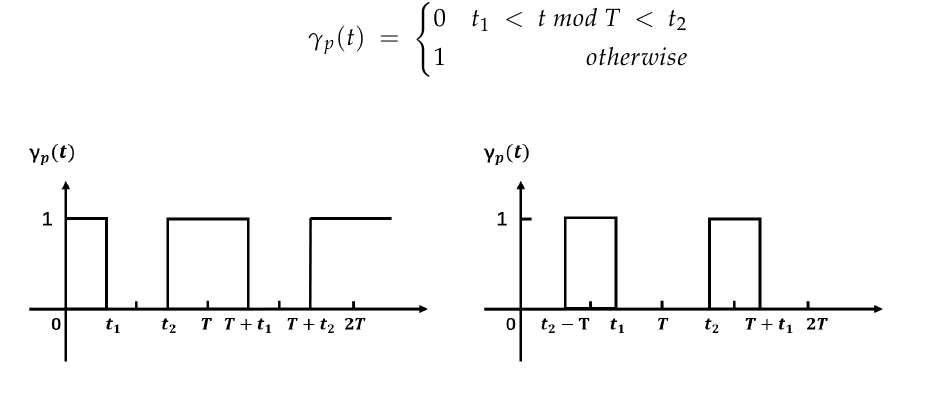
Figure 8. Block effect function of γ p ( t ) with different duty